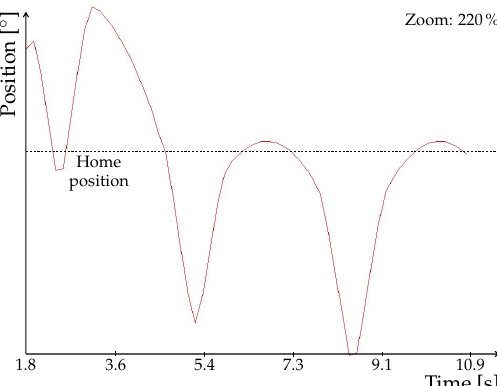
Figure 15. Detail of the signal obtained using OPC UA NET server.